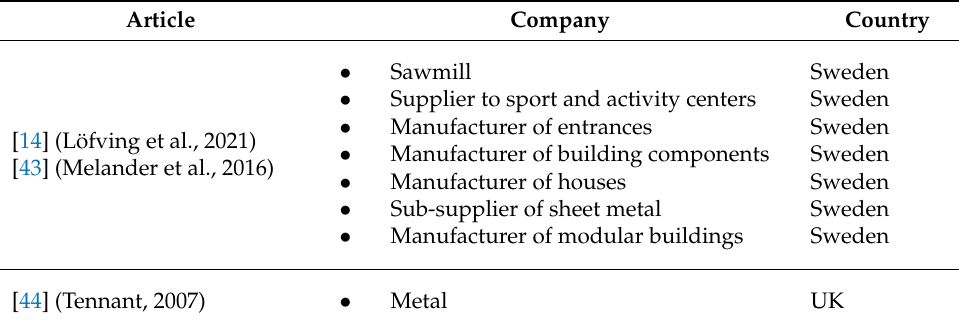
Figure 6. Author’s keywords’ co-occurrence network. Table 6. SMEs (fourth group).